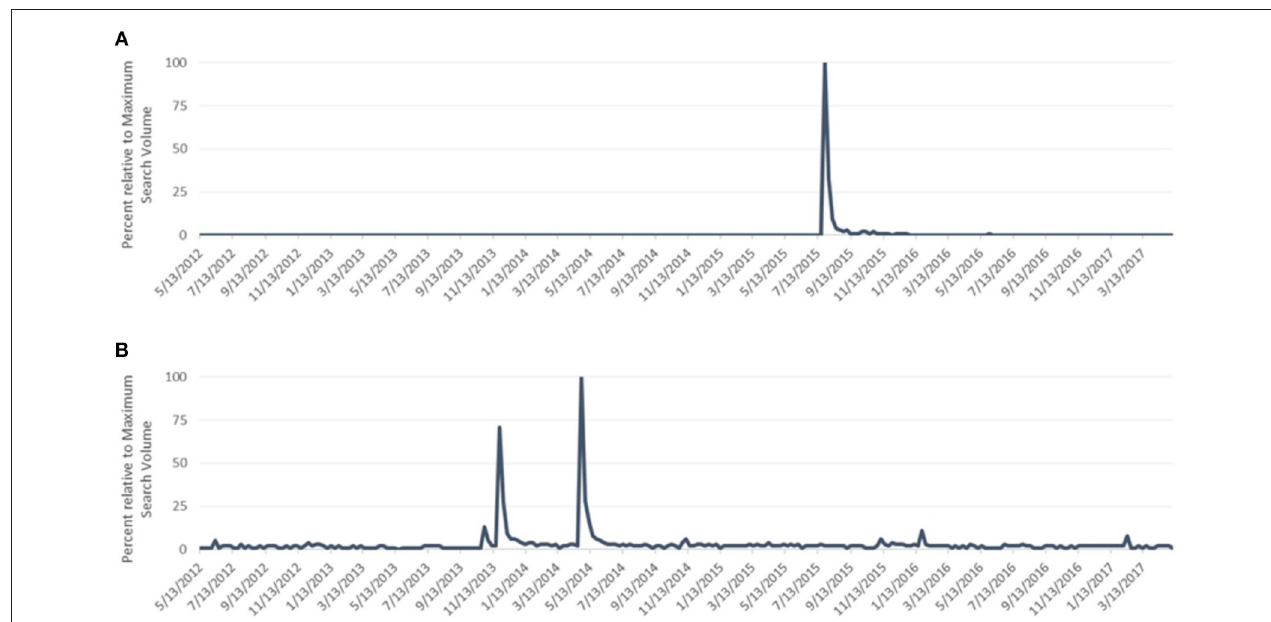
FIGURE 1 | Search volume for “Cecil lion” (A) and “exploding whale” (B) normalized against maximum search volume. Data provided by Google Trend